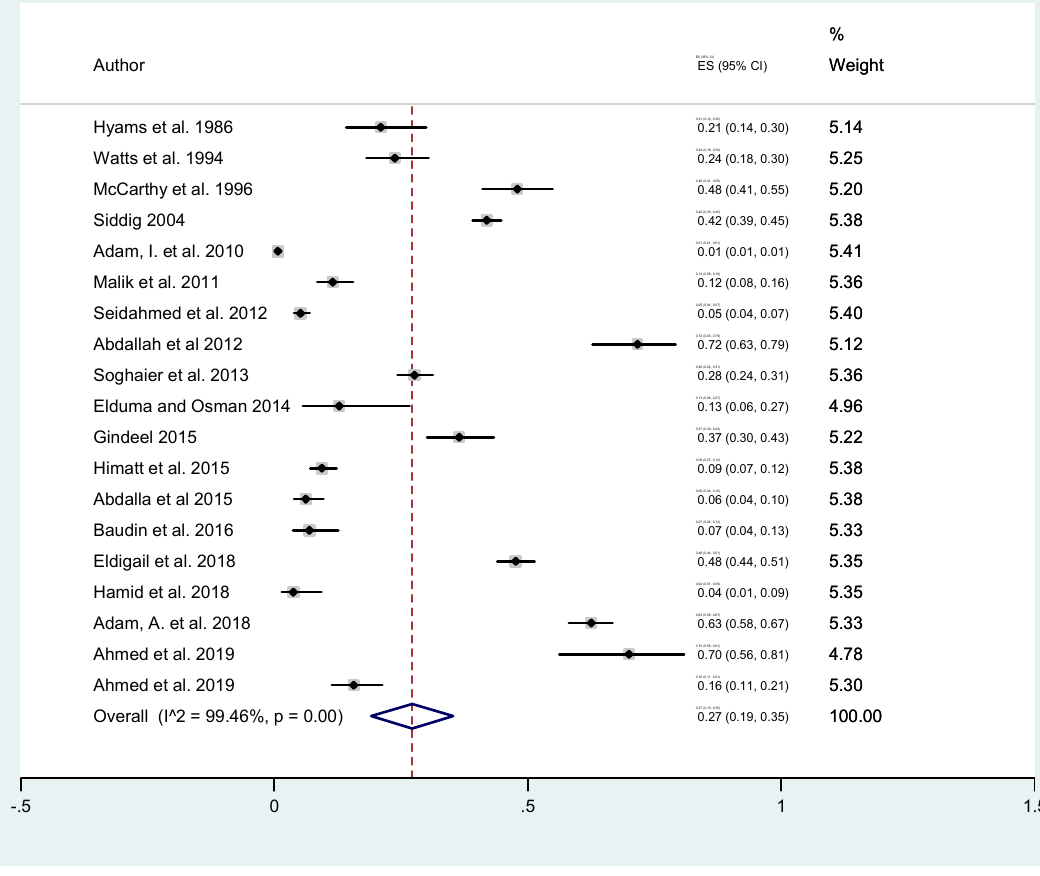
Figure 3. The estimated burden of dengue based on the analysis of all included studies.